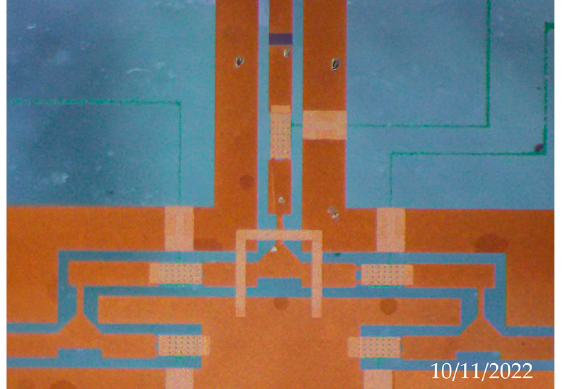
Figure 3. Device process flow.